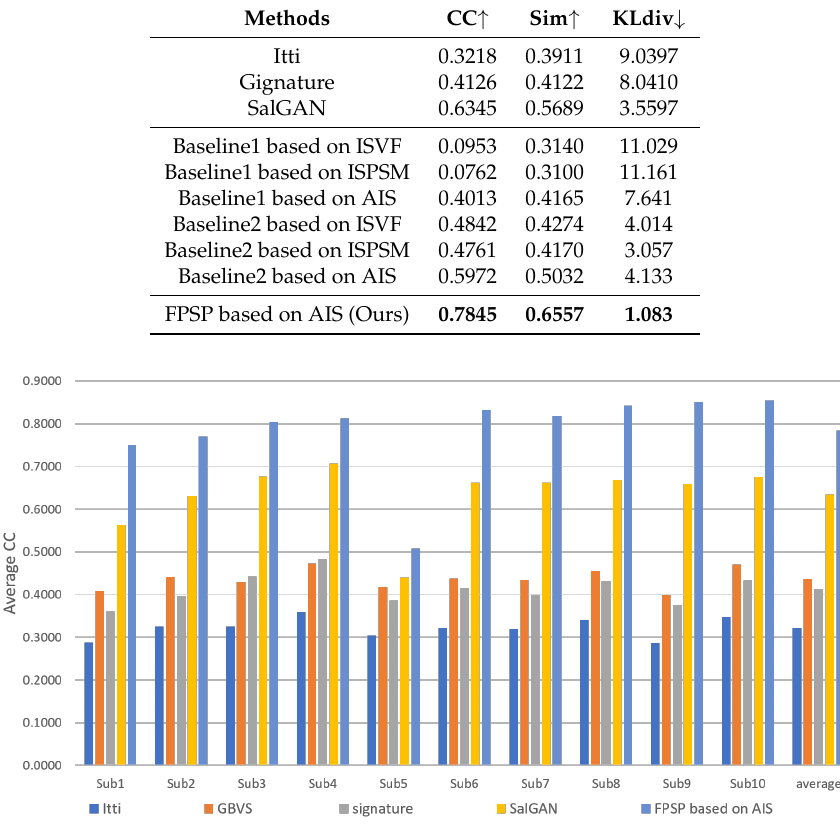
Figure 6. Average CC of each target person ( ↑ ) with comparison to USM prediction